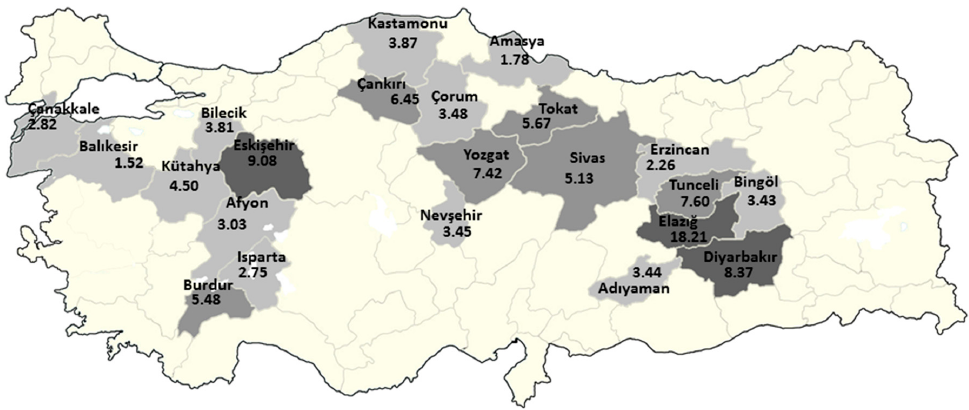
Figure 3. Risk mapping of asbestos exposure-induced mesothelioma in the rural areas of Turkey. Numbers represent Risk Ratio . Table 3. Malignant mesothelioma mortality rate and Risk Ratio (95% CI) by gender, age groups, presence of asbestos in the village, and organization.